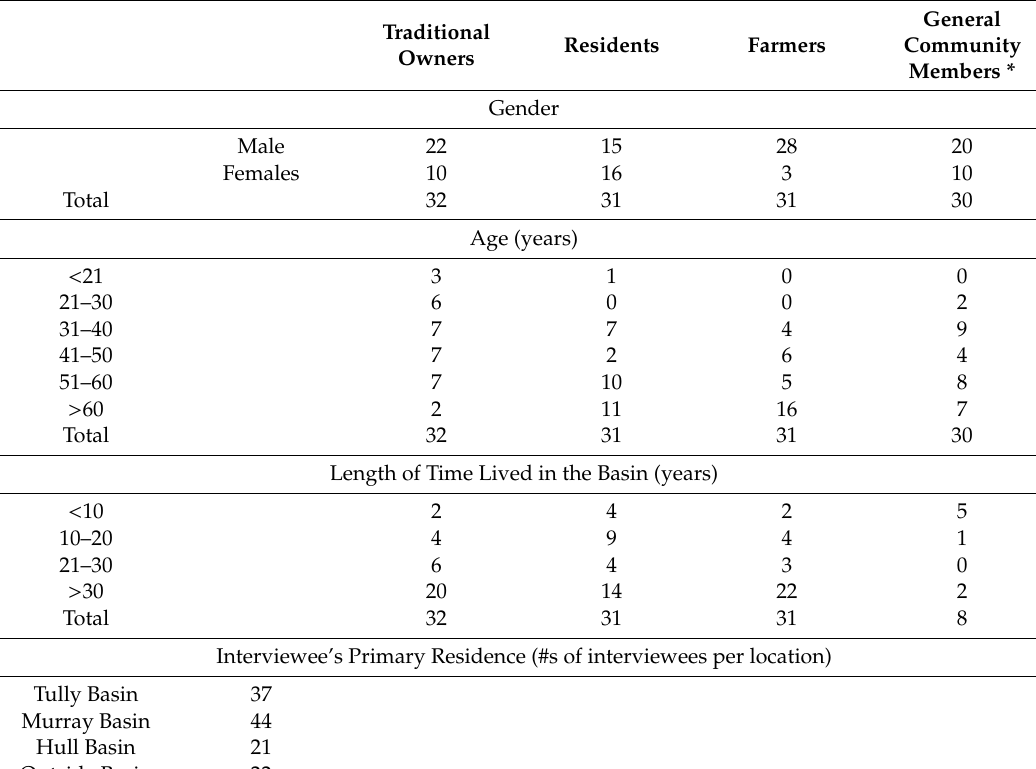
Figure A4. Interview participants by stakeholder group. Total # of Interviews: 124. Total # of FigureA4. Interviewparticipantsbystakeholdergroup. Total#ofInterviews: 124. Total#ofInterviewees Interviewees Living in Basin: 102. Living in Basin: 102. Table A4. Broad characteristics of the interviewees in the Tully